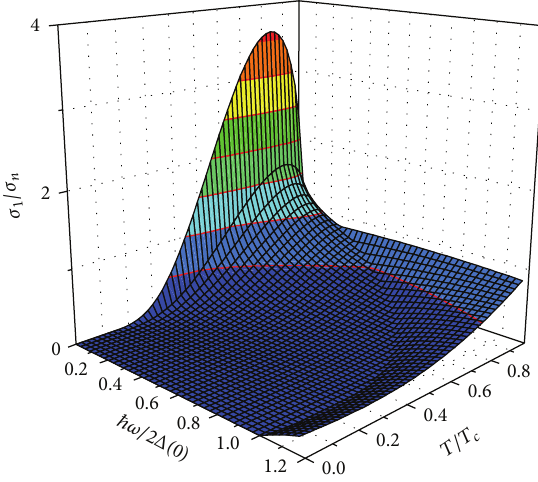
Figure 2: Frequency and temperature dependence of the real part of the conductivity 𝜎 1 /𝜎 𝑛 calculated according the BCS theory [27, 28] with the ratio of the coherence length to the mean free path 𝜋𝜉(0)/2ℓ = 10 . The pronounced maximum for low frequencies at a temperature slightly below 𝑇 𝑐 is the coherence peak. The kink at ℏ𝜔 = 2Δ(0) corresponds to the superconducting gap that decreases with temperature and vanishes for 𝑇 → 𝑇 𝑐 (after